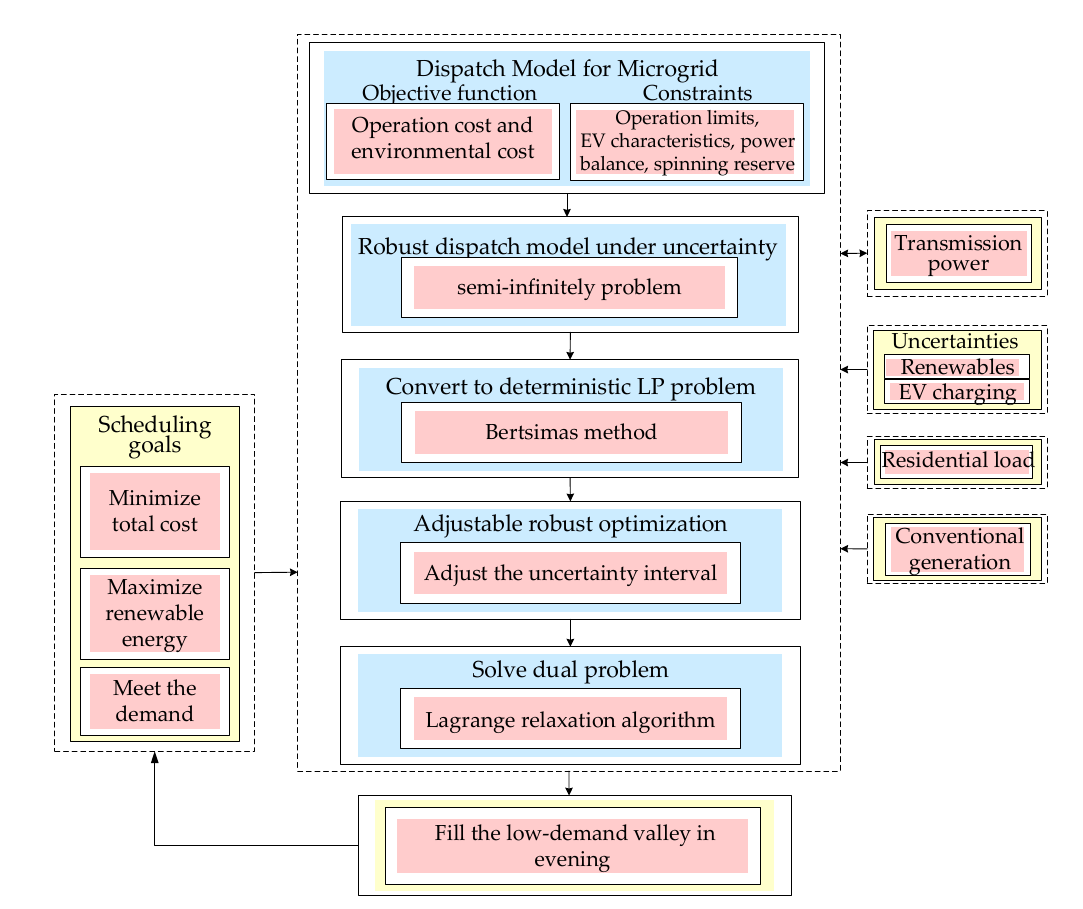
Figure 1. The structure diagram of the scheduling system.